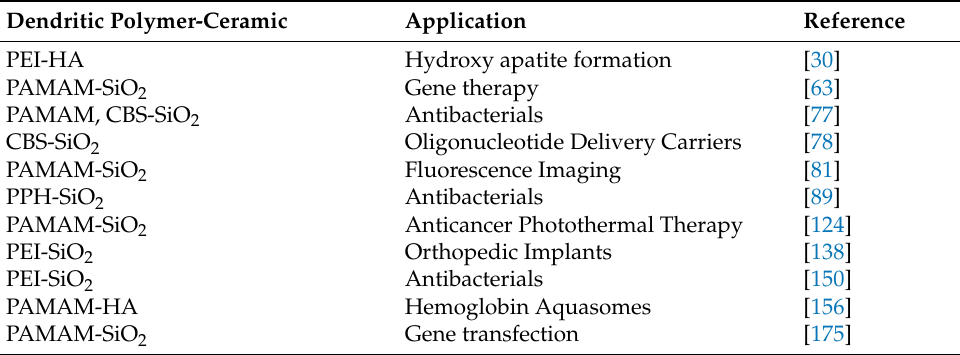
Table 4. Ceramics/dendritic polymer composites applications in